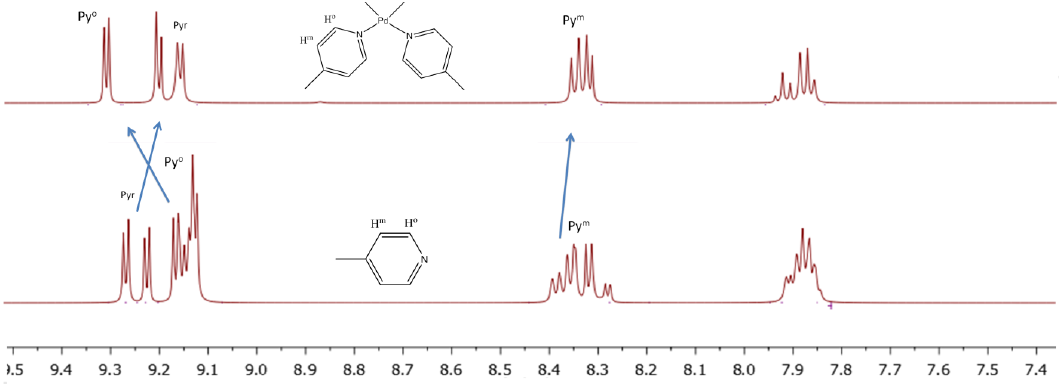
Figure 4. 1 H NMR − spectrum of the cyclic tetramer 2 {(Sn(OH) 2 P) 4 (PdCl 2 ) 4 } and Sn(OH) 2 P 1 .